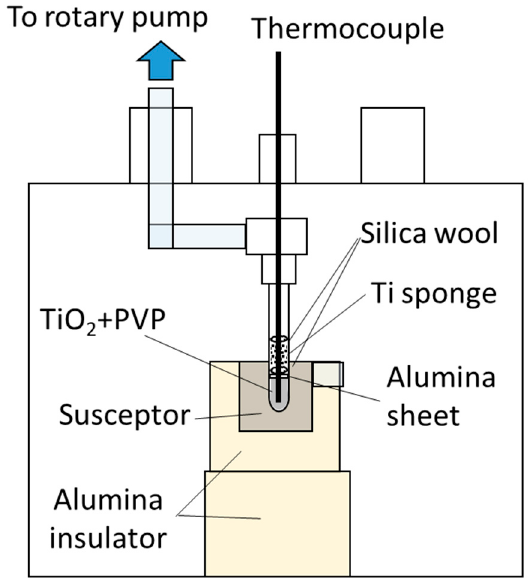
Figure 1. Schematic view of the experimental setup.